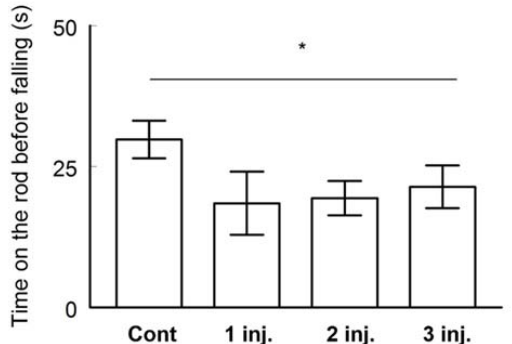
Figure 5. Motor coordination and learning assessed on BALB/C mice by the rotarod test. The time spent on the rod before falling was measured for the four different groups. Data are expressed as mean ± SEM ( n = 3). * indicates significant difference ( p < 0.05) between the control group and all the other administered groups. No significant differences were recorded between the three different AgNPs injected